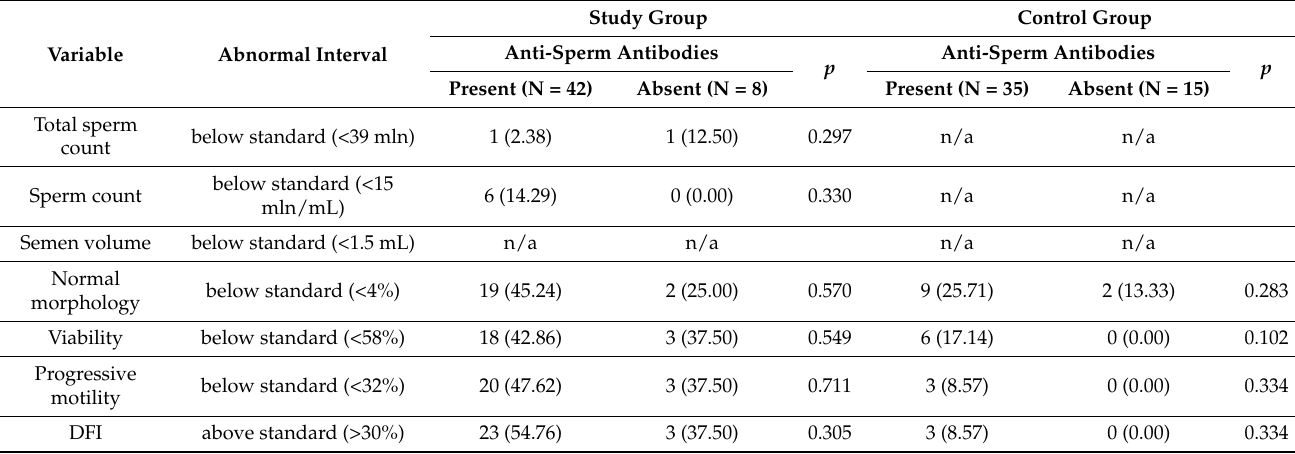
Table 4. Correlations between presence of anti-sperm antibodies and abnormal semen parameters and in the study group and the control group.